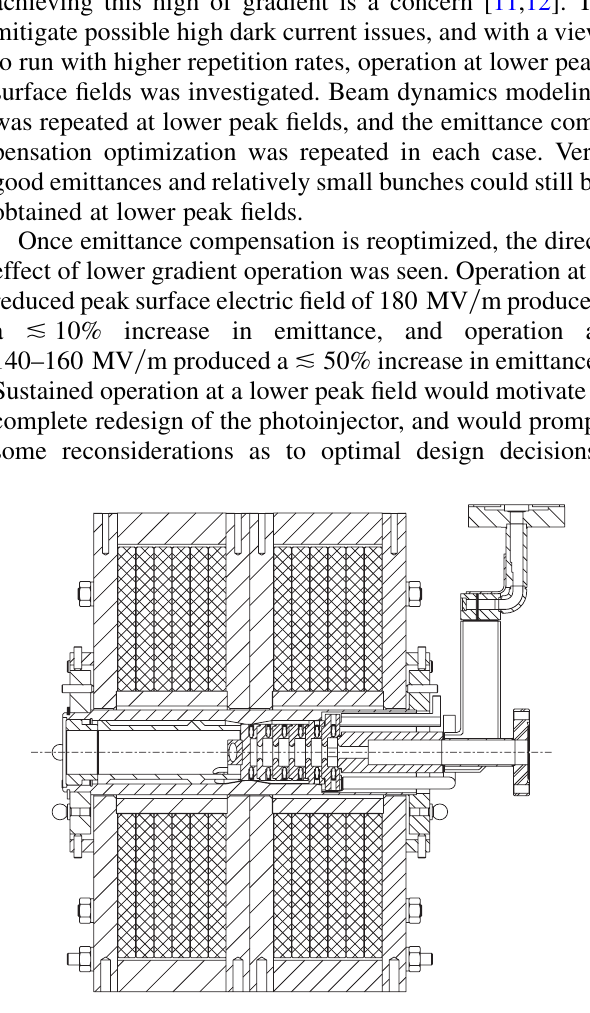
FIG. 8. Schematic of the emittance compensation solenoid fitted with the Mark 1 rf gun and precision alignment sleeve.